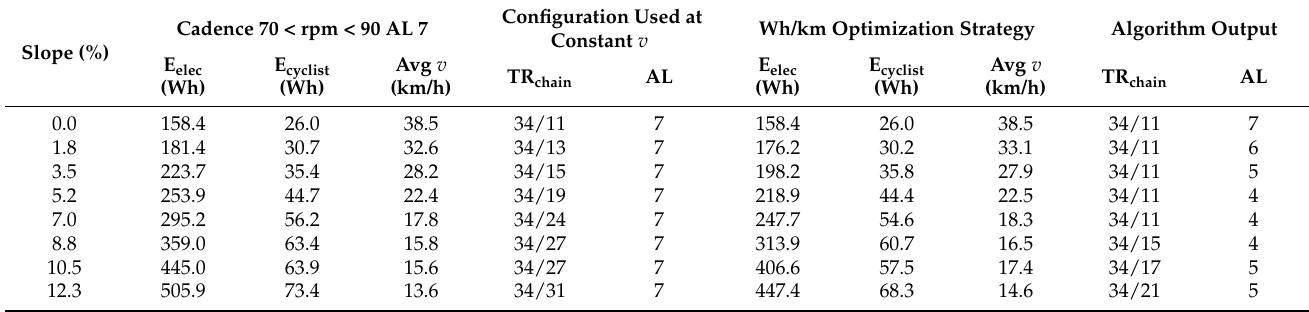
Table 8. Performance of strategies three and one under e-bike and human power (E stands for energy, v stands for speed, TR chain stands for chain transmission ratio and AL stands for assistance level).